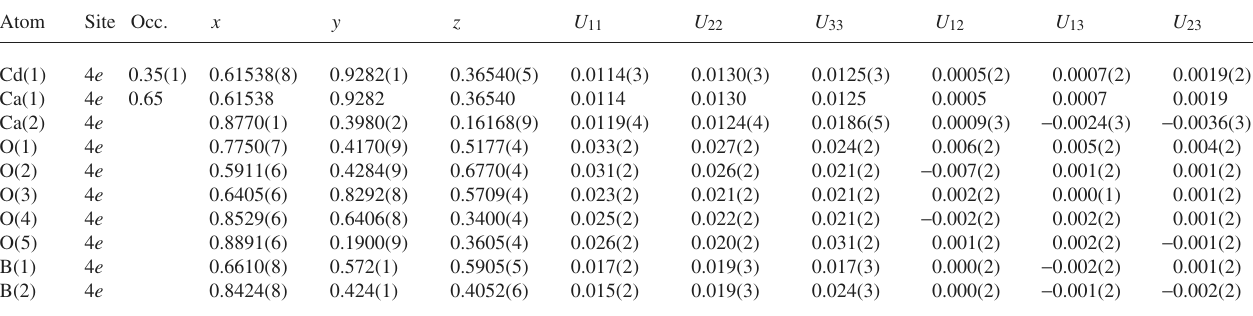
Table 2. Atomic coordinates and displacement parameters (in Å 2 ) .